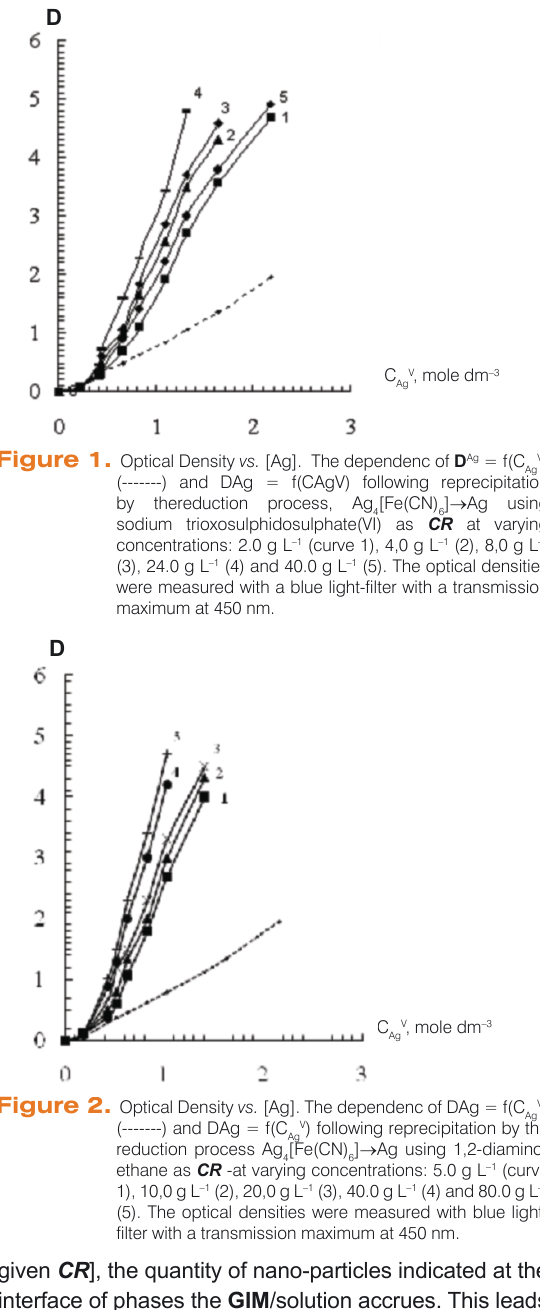
Figure 2. Optical Density vs. [Ag]. The dependenc of DAg = f(C V ) Ag (-------) and DAg = f(C AgV ) following reprecipitation by the reduction process Ag [Fe(CN) ] → Ag using 1,2-diamino- 4 6 ethane as CR -at varying concentrations: 5.0 g L –1 (curve 1), 10,0 g L –1 (2), 20,0 g L –1 (3), 40.0 g L –1 (4) and 80.0 g L –1 (5). The optical densities were measured with blue light- filter with a transmission maximum at 450 nm.